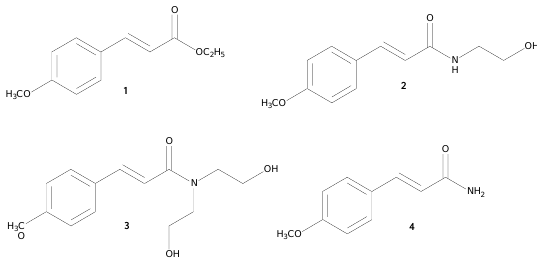
Figure 1. Ethyl p -methoxycinnamate ( 1 ) and its cinnamamide